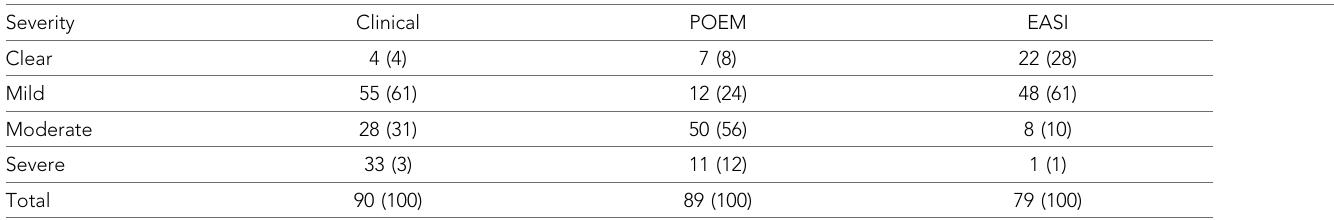
Table 2. Eczema severity by method of